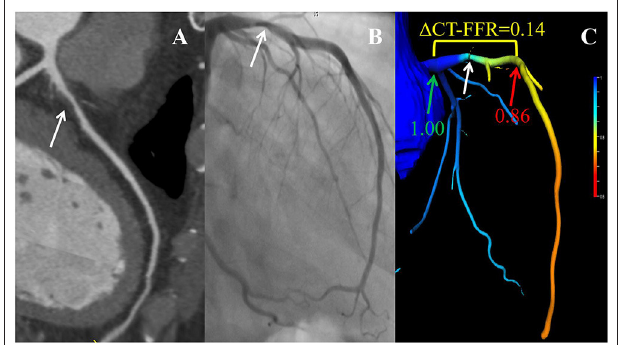
FIGURE 3 | Example of a 56-year-old man with chest pain. CCTA (A) and ICA (B) as well as CT-FFR (C) showing an LAD with moderate stenosis (white arrow). 1 CT-FFR was the difference of values obtained by subtracting CT-FFR distal (red arrow) from CT-FFR proximal (green arrow), where CT-FFR proximal and CT-FFR distal were defined as the values proximal or distal within 2cm to the lesion plaque, respectively. CCTA, coronary computed tomography angiography; ICA, invasive coronary angiography; CT-FFR, computed tomography-derived fractional flow reserve; LAD, left anterior descending coronary artery.